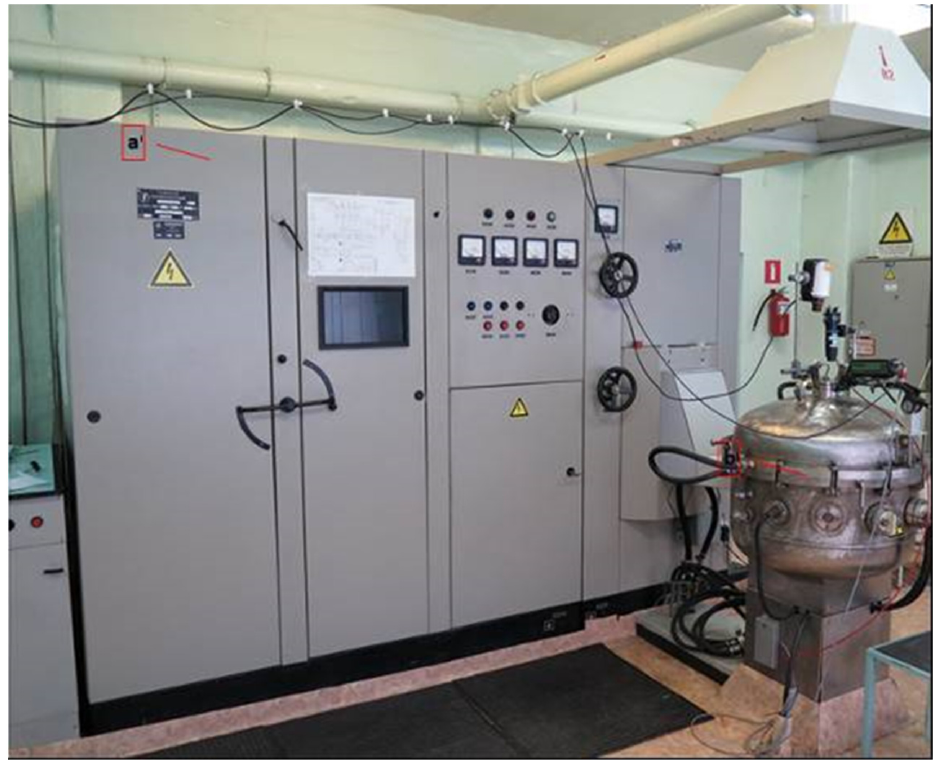
Figure 2. Outer view of the “VCG-135” test bench.